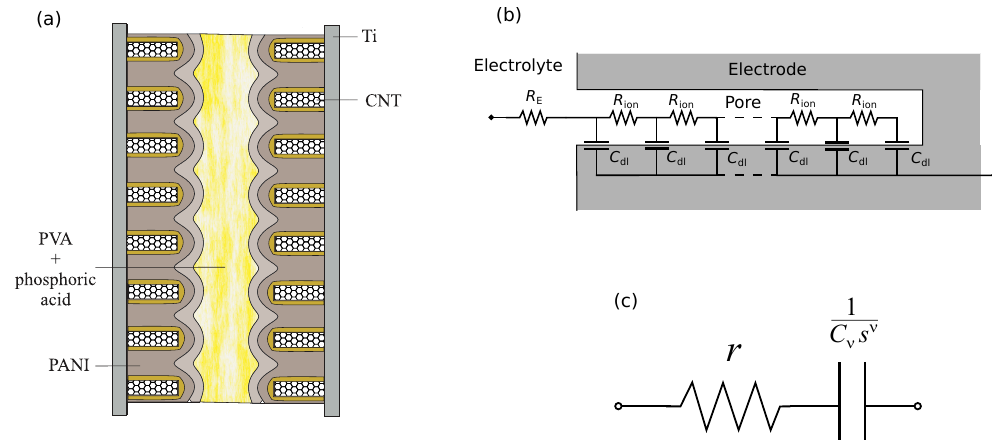
Figure 3. Schematic representation of a cell with electrodes based on vertically aligned MWCNT array/PANI composite ( a ), RC transmission line (De Levie model) for a single pore ( b ), and the simplest equivalent circuit model of a supercapacitor ( c